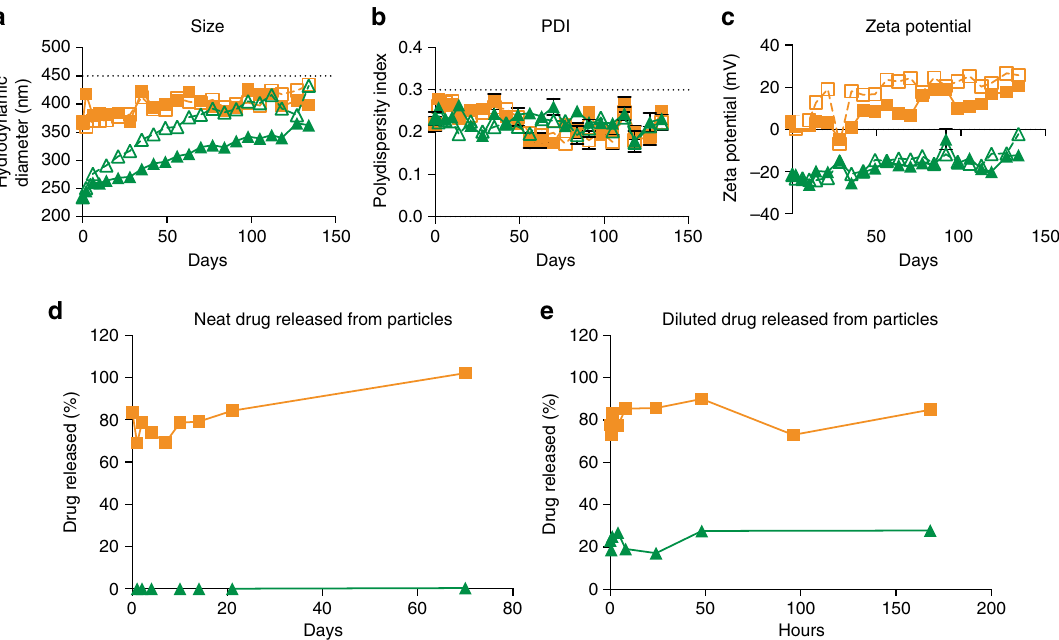
Fig. 2 Nanoformulation stability and release kinetics. Nanoformulations were synthesized by high-pressure homogenization using poloxamer 407 (P407) as the excipient for DTG and MDTG. a – c Formulation stability (up to 134 days) was measured by ( a ) particle hydrodynamic diameter (size), ( b ) polydispersity index (PDI), and ( c ) zeta potential as determined by dynamic light scattering (DLS). NDTG and NMDTG stability were tested at both 4 °C and 25 °C. d , e Nanoparticle release kinetics were assessed by drug released from the nanoparticles during storage, in ( d ) freshly manufactured (neat) formulation and ( e ) formulation diluted for in vivo administration. All results are shown as the mean ± SEM of at least three